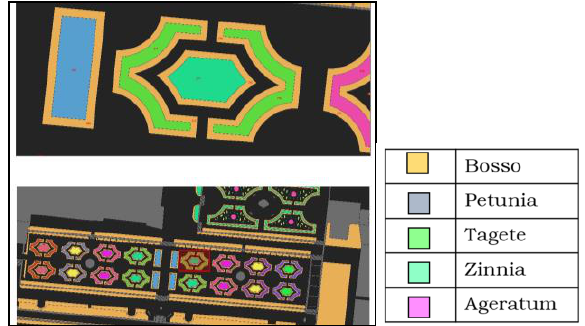
Figure 13. An example of thematic